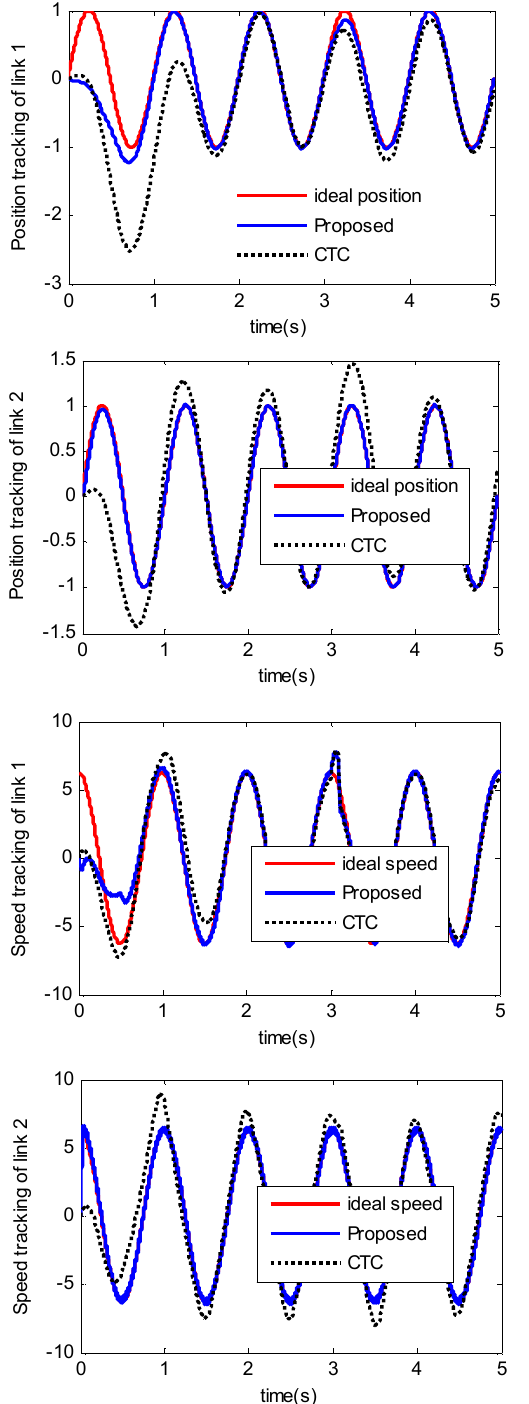
Fig. 2. Results for disturbance